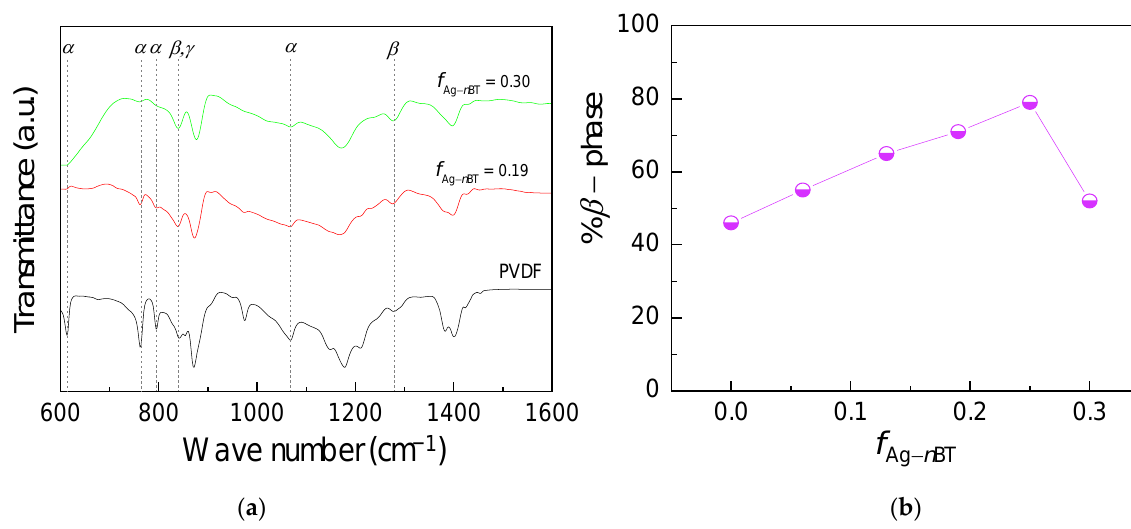
Figure 5. ( a ) FTIR spectra of PVDF and the Ag- n BT/PVDF-(0.2) μ BT composites and ( b ) % β -phase of the Ag- n BT/PVDF- (0.2) μ BT composites with various f Ag-nBT.